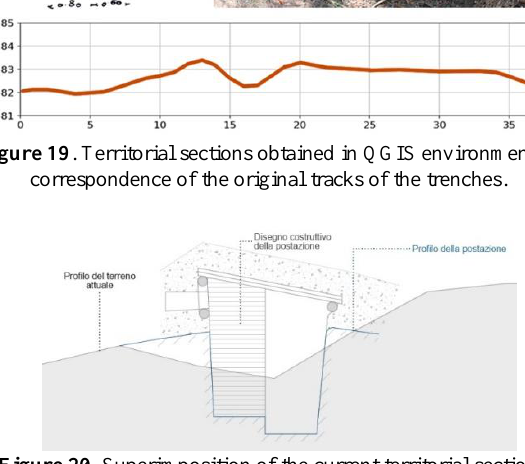
Figure 20 . Superimposition of the current territorial section (Lidar data) with the profiles drawn on the project documentation (blue